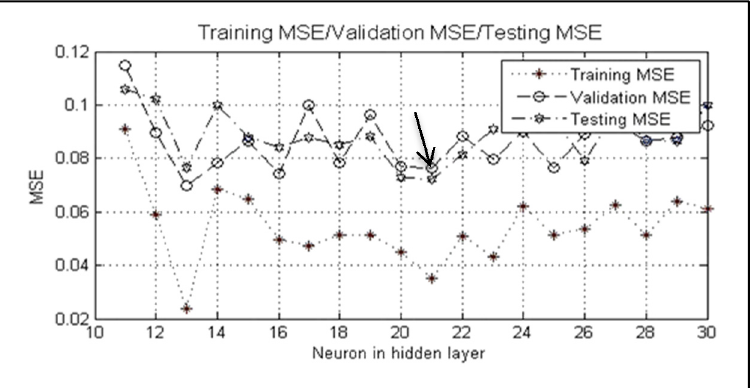
Figure 17. Mean square error curve with the increased neurons in the hidden layer.